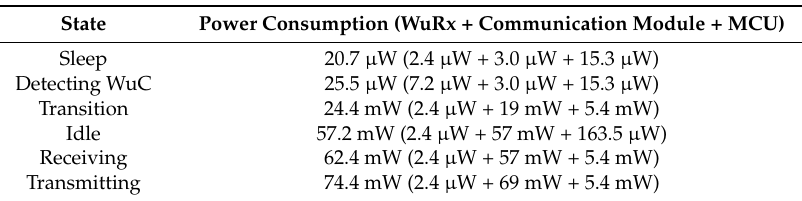
Table 3. A sensor node’s power consumption at each